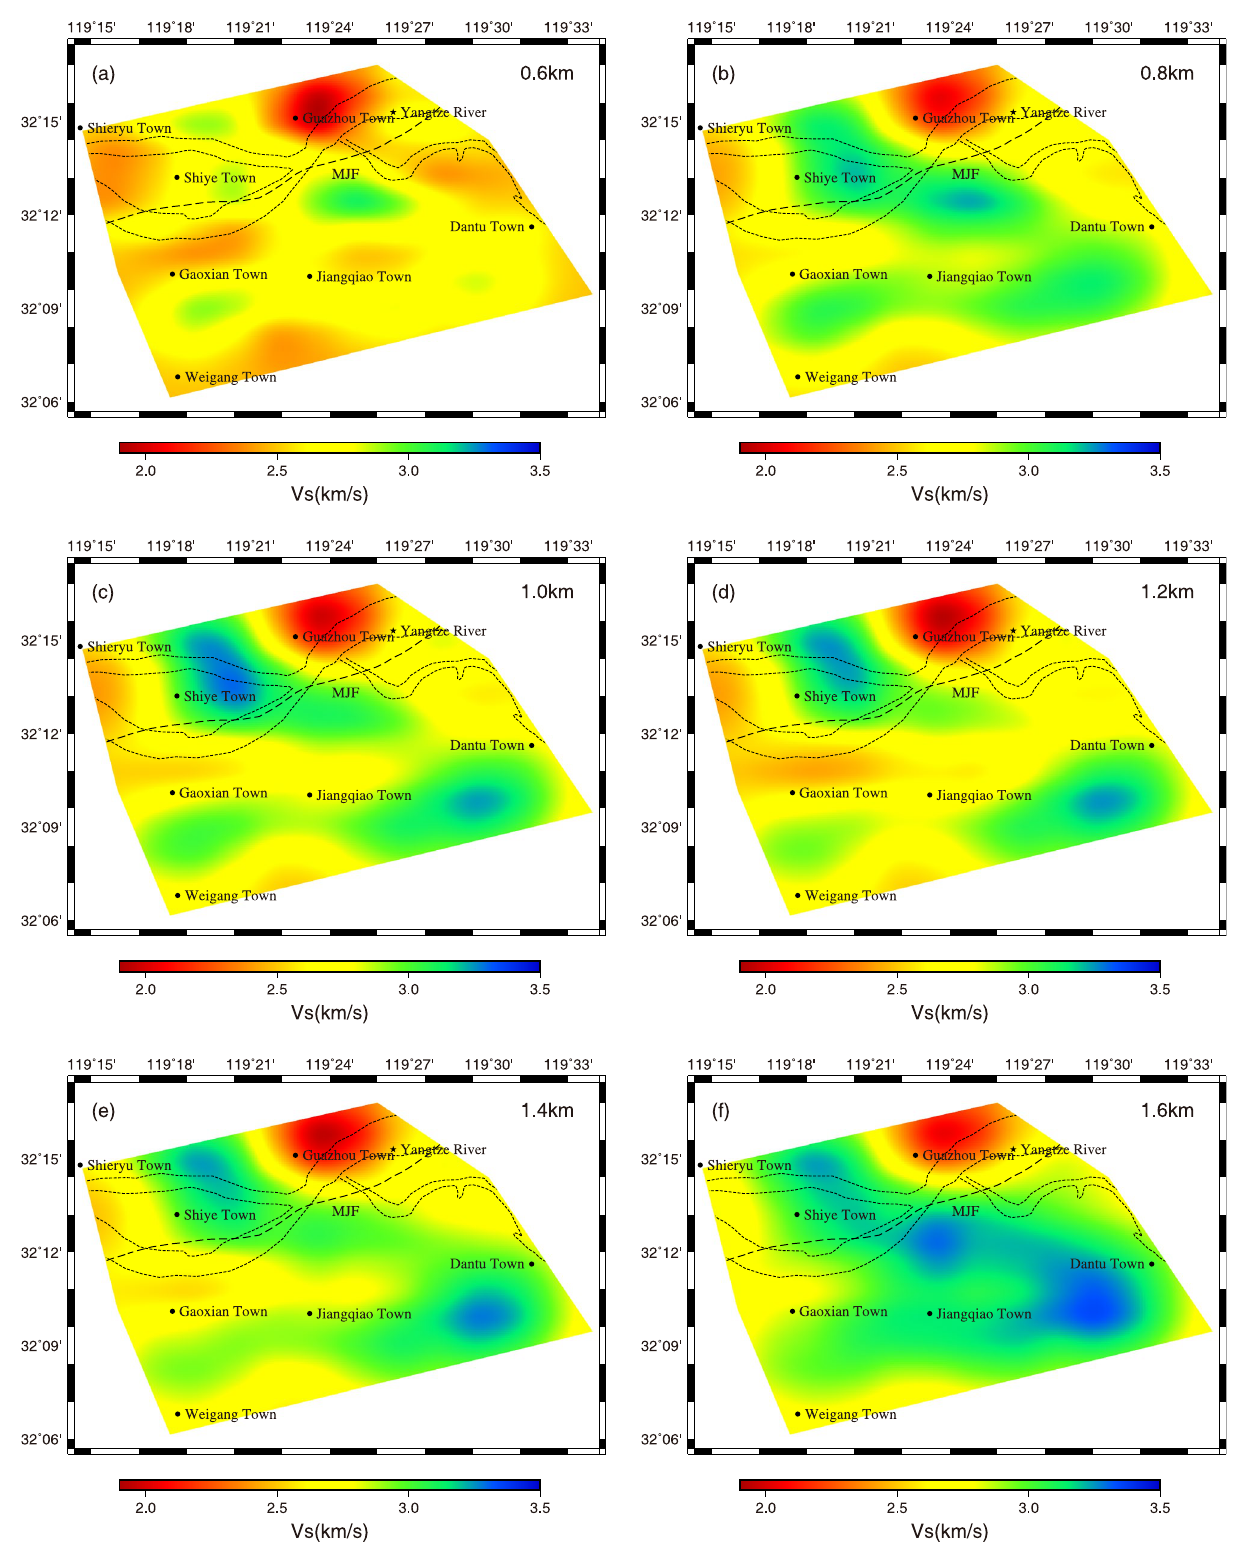
Figure 8. Map view of the V s model at depth of ( a ) 0.6, ( b ) 0.8, ( c ) 1.0, ( d ) 1.2, ( e ) 1.4, and ( f ) 1.6